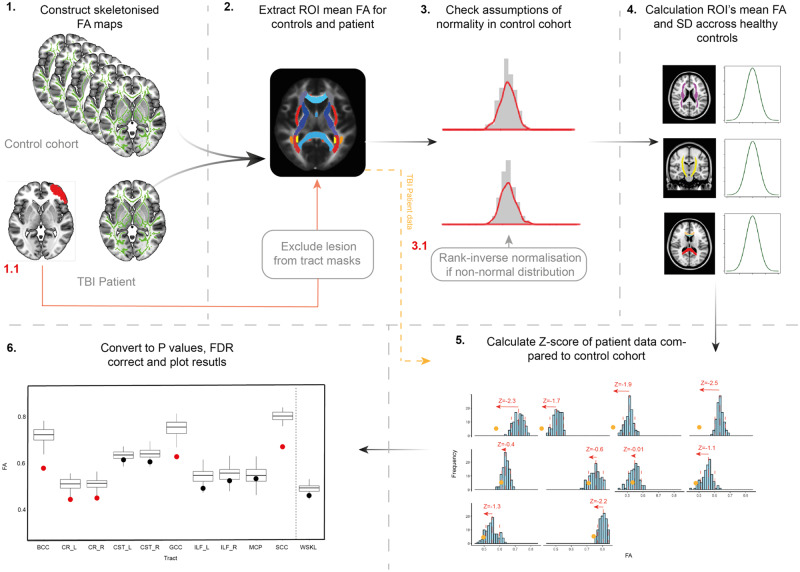

DTI diagnostic pipeline processing steps. 1: Skeletonized FA maps are derived for the patient of interest and the comparative control group using TBSS. 1.1: If a patient has evidence of contusion or missing brain, these areas are manually delineated using in house software (ImSeg) to produce a lesion mask. The lesion mask is then registered to standard MNI152 1 mm space and subtracted from tract masks so that these regions are excluded from influencing subsequent FA measures. 2: Skeletonized FA maps from controls and individual patients are tract masks to extract mean FA value for each region of interest (ROI) for each individual. 3: Control FA distributions are assessed for assumptions of normality using histograms, QQ plots and Shapiro-Wilks tests. 3.1: If assumptions of normality are violated, rank-inverse normalization is applied. 4: Control group mean FA and SD for each region of interest is then calculated for use in Z-scoring. 5: Z-scores for each patient are calculated. 6: Z-scores for a patient are then converted to P-values (95% CI, two tailed) and corrected for multiple comparisons using FDR. Whole brain FA skeleton is calculated as a stand-alone test. Individual patient data are then plotted against control group and significantly lower FA in patients are highlighted in red for ease of interpretation.